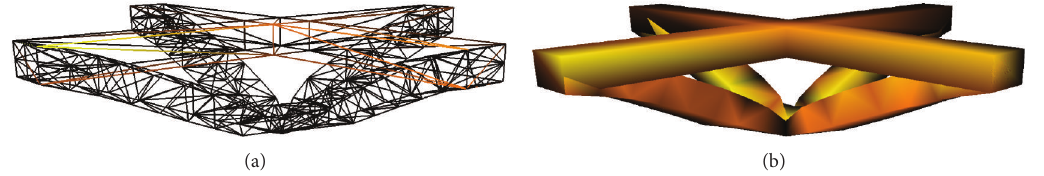
Figure 9: Nonlinear FEM results for the both proposed and Pedersen’s methods: (a) initial and final wireframe meshes are overlaid; (b) initial and final shaded meshes are overlaid.